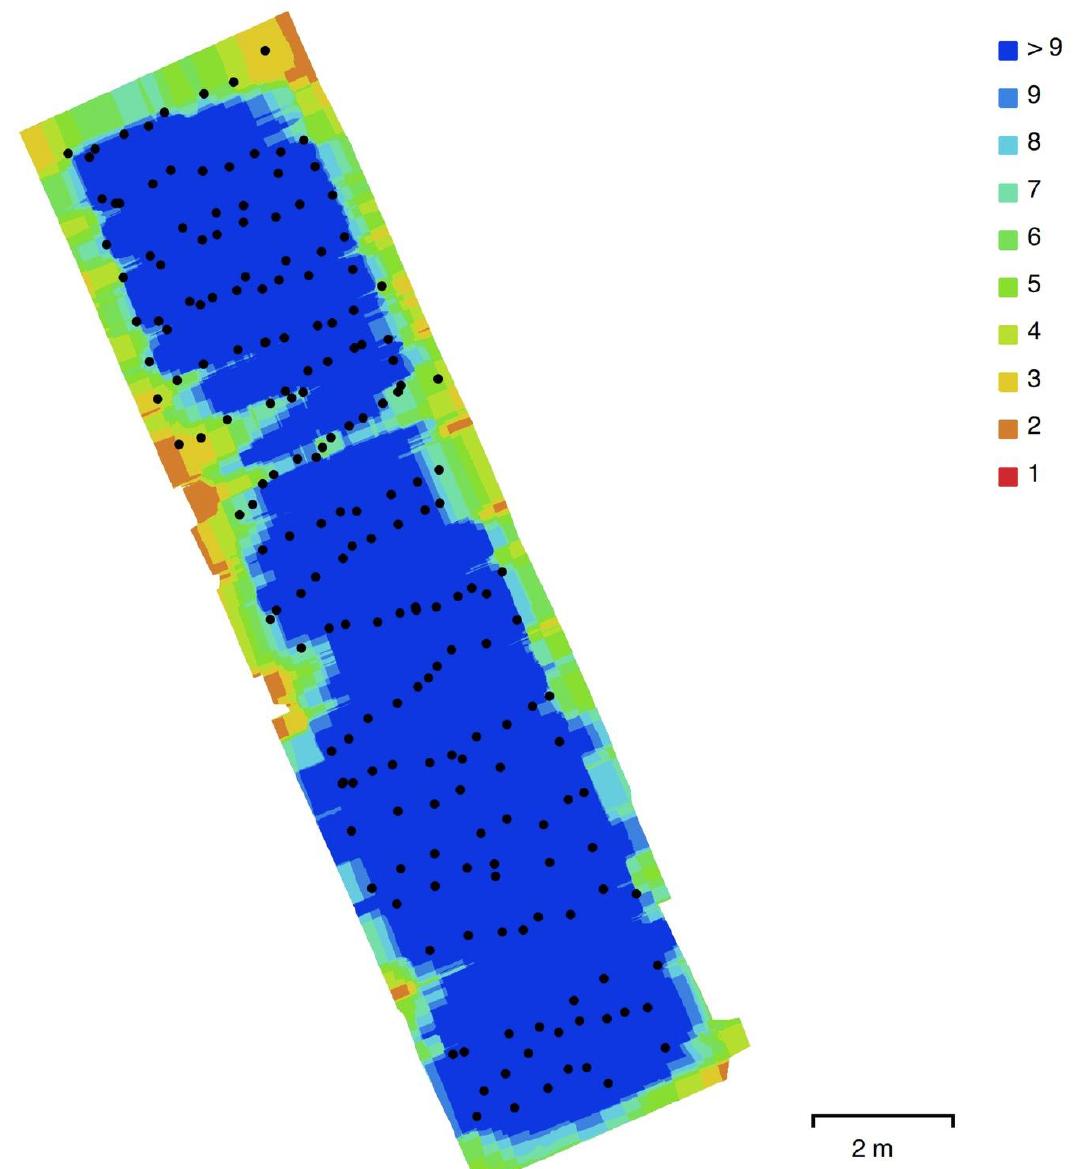
Figure 5. Camera locations (black dots) and image overlap. Colors represent the number of photos where each point appears.